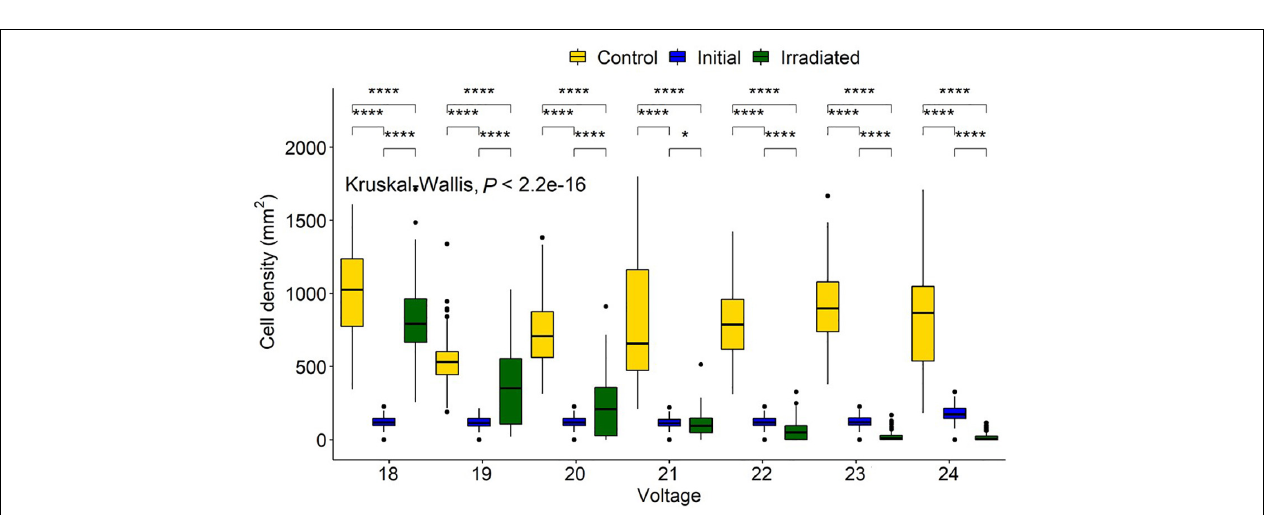
FIGURE 7 | Navicula incerta density and range after UV irradiance over varying duty cycles with respective irradiance dosages. Duty cycling periods display minutes in which the UV light was turned on to minutes it was turned off (On:Off). Fluence dosages were determined as 0.47, 0.94, 2.34, 4.68, and 9.35 J/cm 2 for each respective duty cycle 0.50:19.50, 1:19, 2.50:17.50, 5:15, and 10:10 (irradiated: no irradiance). Irradiated and initial intercept point (between 0.94 and 2.34 J/cm 2 ) indicates the fluence required to reduce density below initial levels.